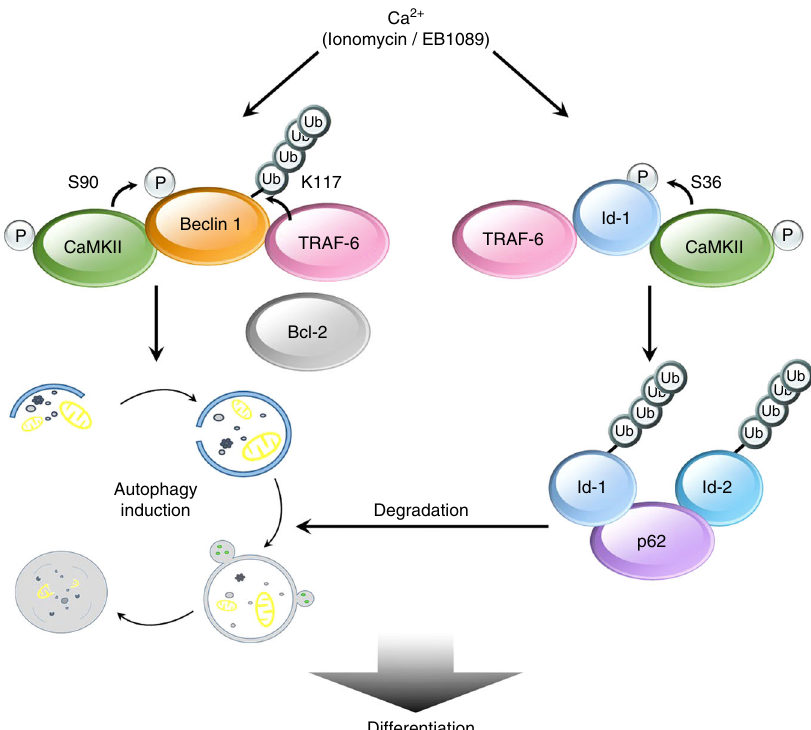
Fig. 9 Model of Beclin 1 and Ids regulation by CaMKII. Proposed model for CaMKII-mediated regulation of Beclin 1 and Id